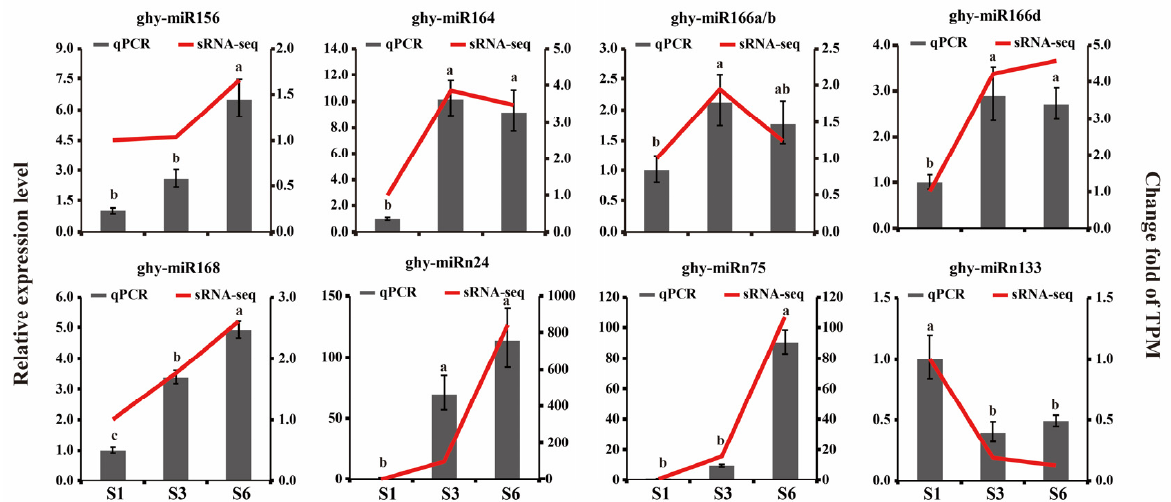
Figure 6. Validation of the expression profiles of DEMs at three growth stages of ray florets identified by sRNA-seq using qRT-PCR. Dark gray columns represent the relative expression levels of DEMs testing by qRT-PCR; the red lines indicate the change fold of transcripts per million mapped reads (TPM). Relative expression was normalized to the reference genes small nuclear RNA (snRNA) U6 and the expression level of S1 was defined as “1”, different letters indicate significant differences of qRT-PCR data ( p < 0.05).